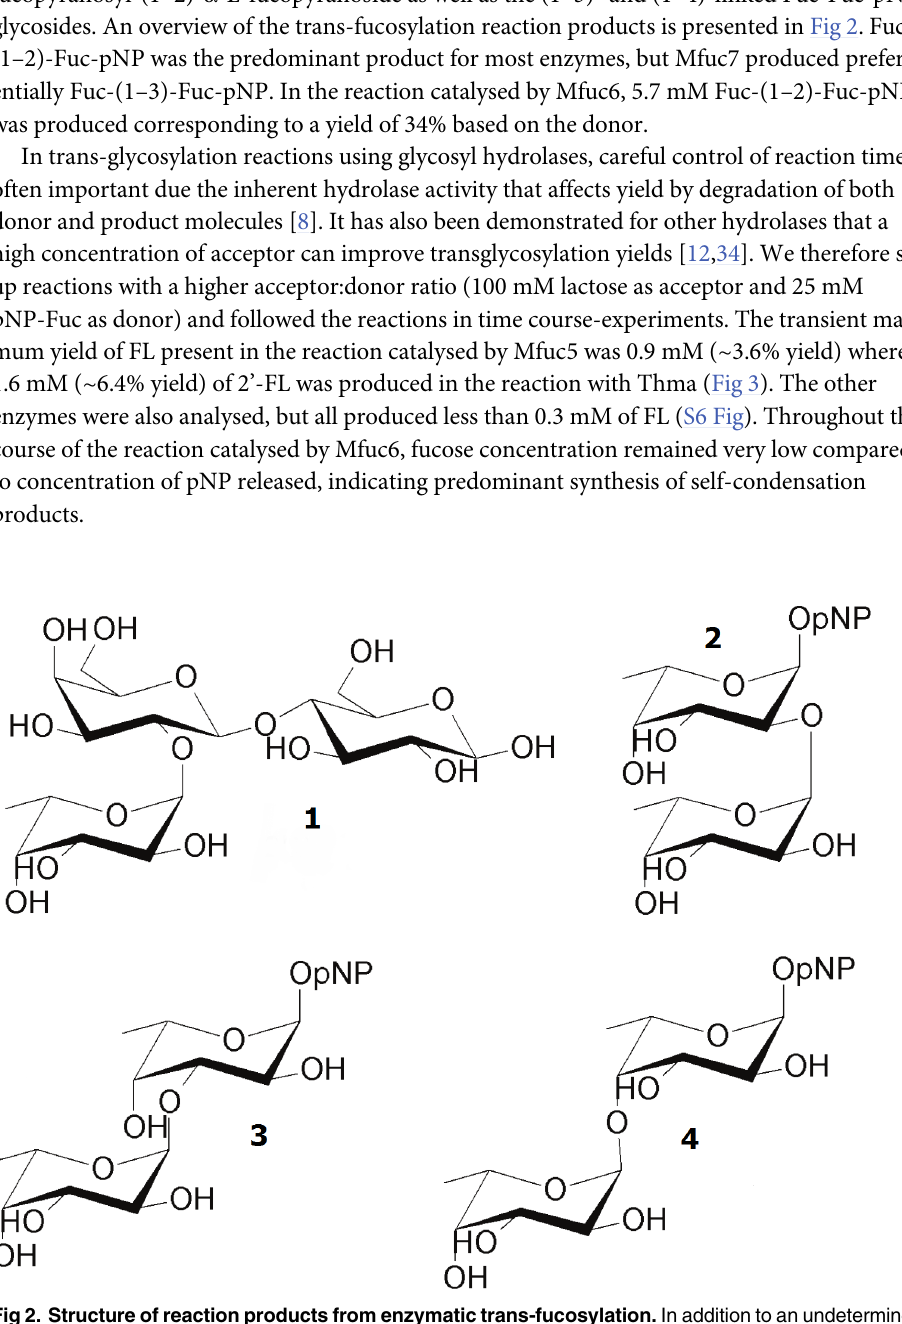
Fig 2. Structure of reaction products from enzymatic trans-fucosylation. In addition to an undetermined FL, 1: the HMO 2 ’ -FL and the self-condensation products 2 : Fuc p -(1 – 2)-Fuc p -pNP, 3 : Fuc p -(1 – 3)-Fuc p -pNP, 4 : Fuc p -(1 – 4)-Fuc p -pNP were